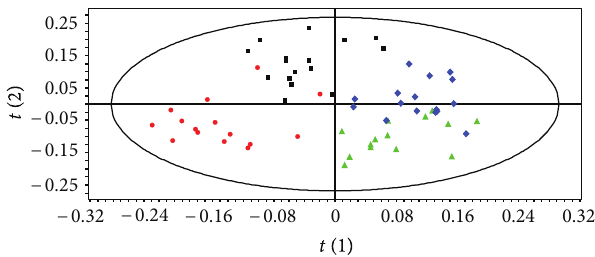
F 5: PLS-DA score plot based on the aqueous liver extracts sampled from nonexposed male (green